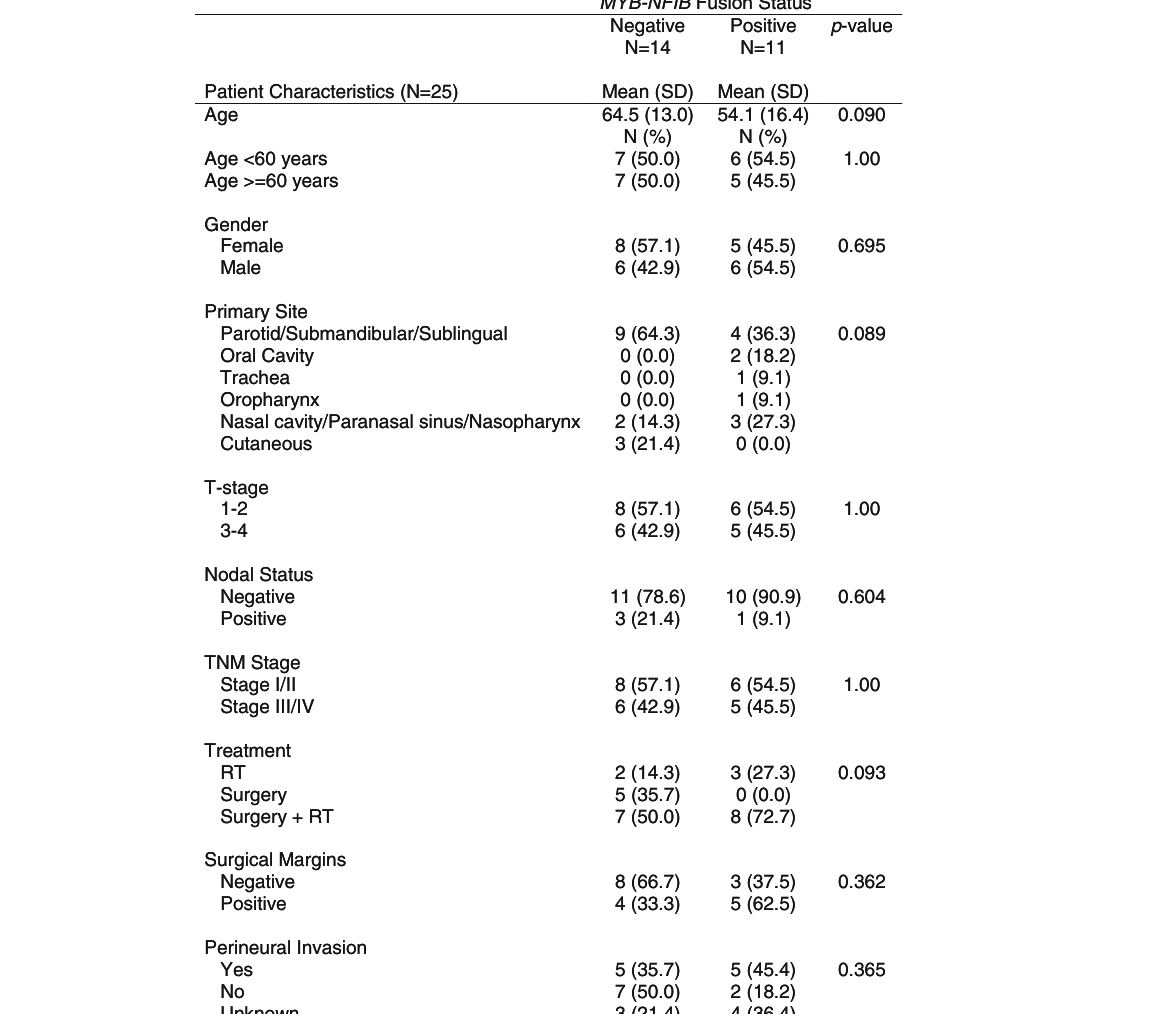
Table 1 Clinocopathological characteristics of Patients Diagnosed with Adenoid Cystic Carcinoma at Tom Baker Cancer Centre 2007 – 2013